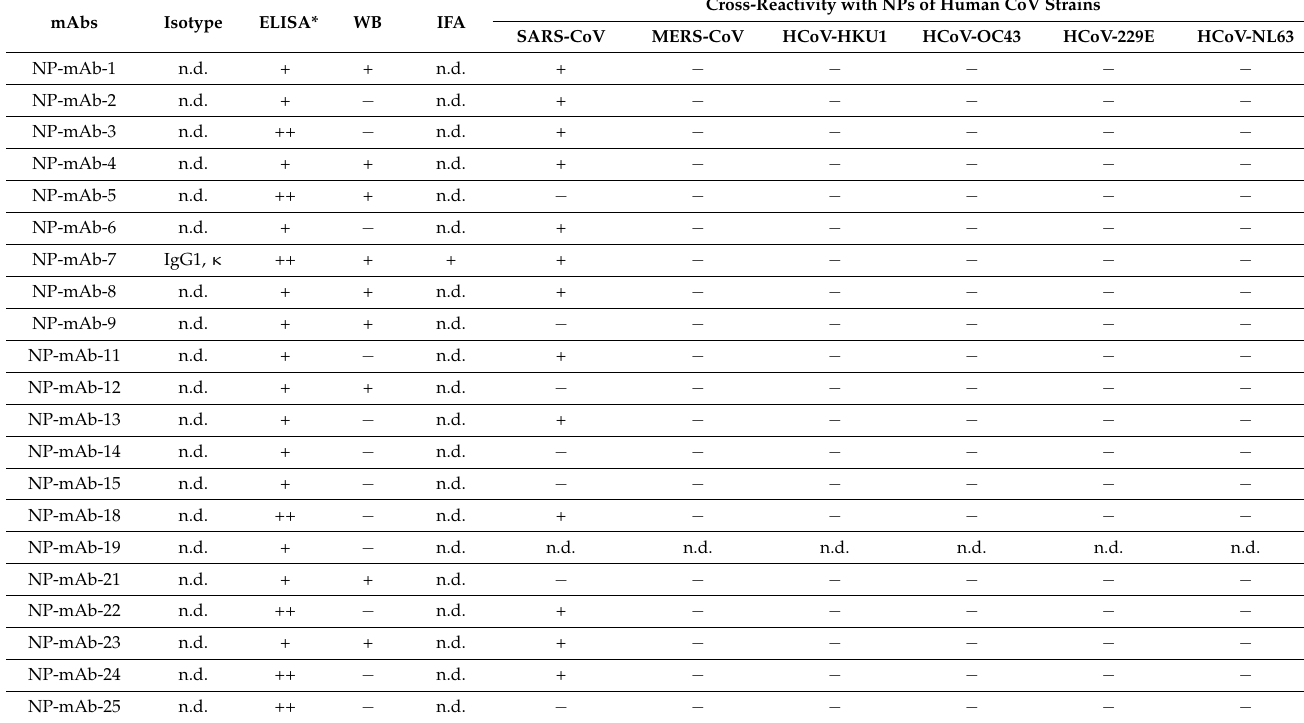
Table 1. Characterization of the mAb activities against the NP of